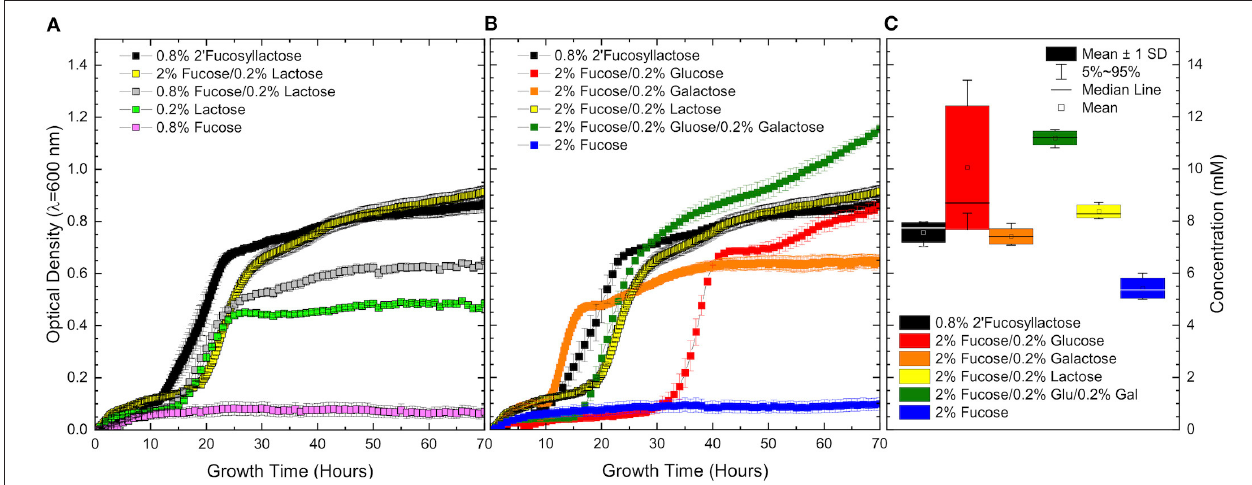
FIGURE 2 | Growth curves of ATCC 15697 growth in (A) co-fermentation of excess fucose and limiting lactose as compared to 2 ′ fucosyllactose. Co-fermentation of fucose and limiting lactose shows similar behavior to fermentation of 2 ′ fucosyllactose and results in increased growth over individual carbohydrate sources. Co-fermentation of (B) excess fucose and limiting concentrations of mono- and di-saccharide components of 2 ′ fucosyllactose shows a consistent synergistic effect. 1,2-Propanediol production (C) during co-fermentation is equal to or higher than 2 ′ fucosyllactose and higher than growth on fucose as a sole carbohydrate source. Error bars denote standard error of the